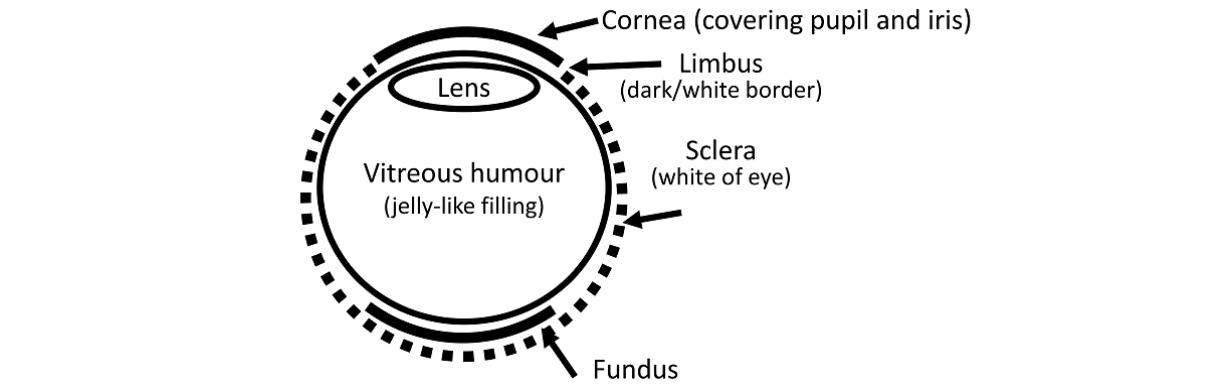
Figure 1. Structure of the eye.